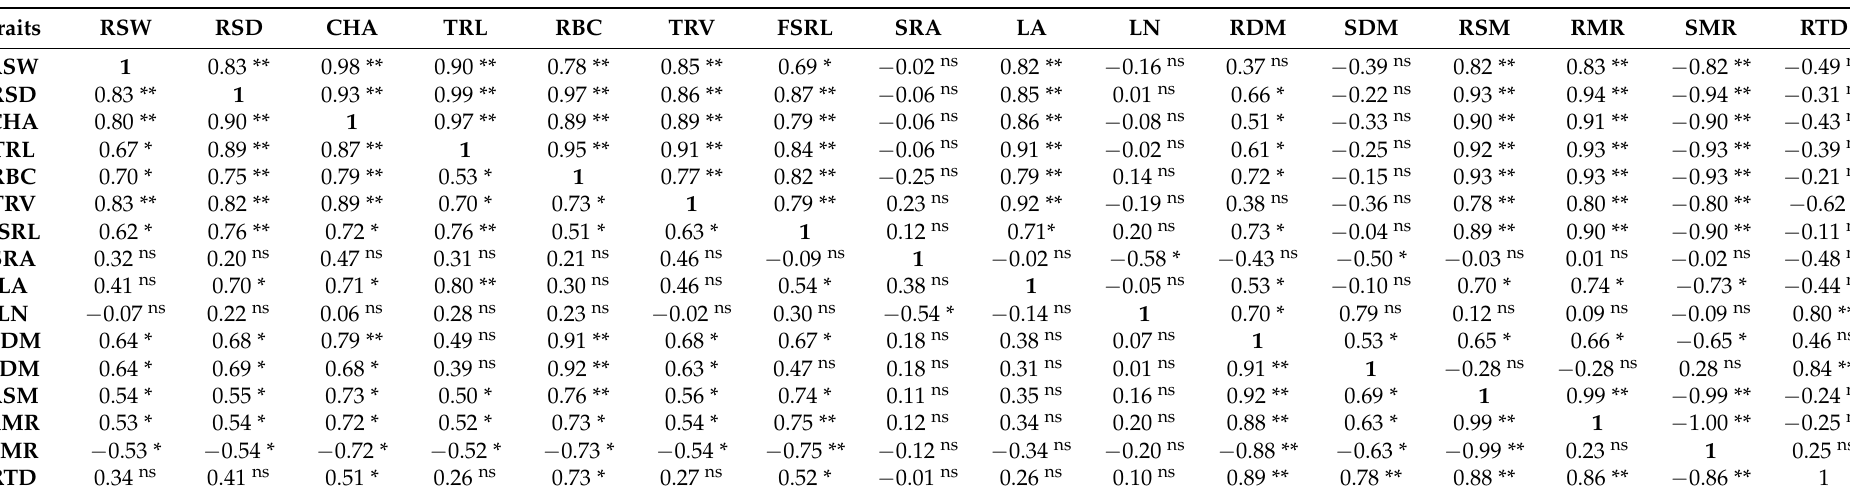
Table 5. Pearson correlation coefficients for evaluated traits (root system architectural traits, leaf traits, allometry) under non-stressed conditions ( bottom diagonal ) and water stress conditions ( top diagonal